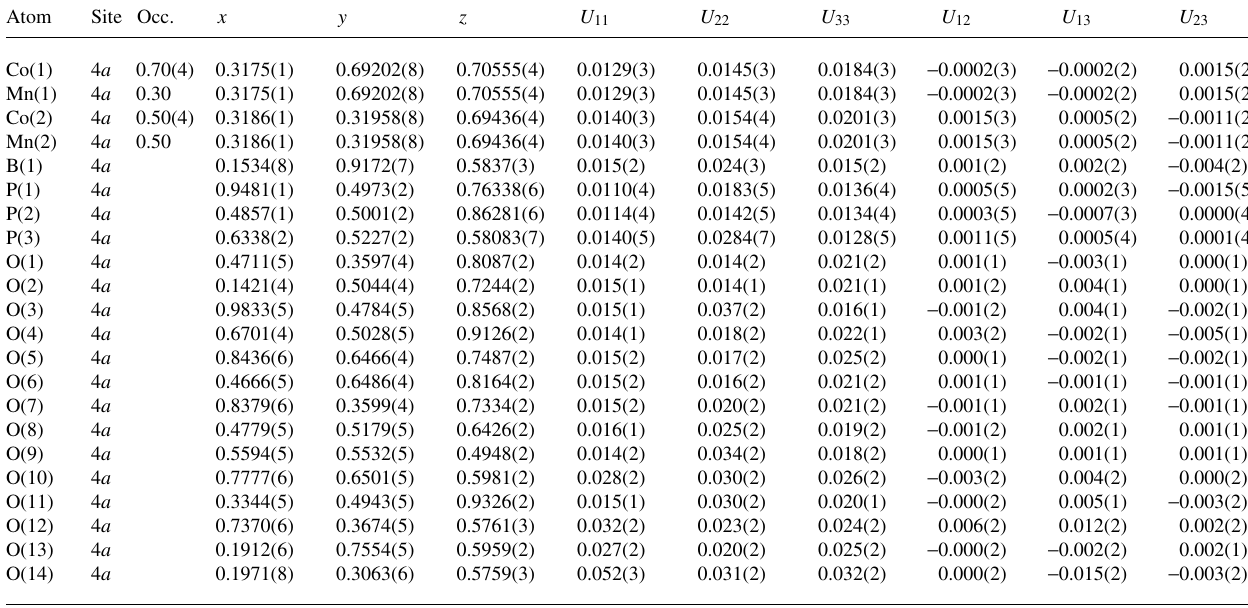
Table 3. Atomic coordinates and displacement parameters (in Å 2 ) .